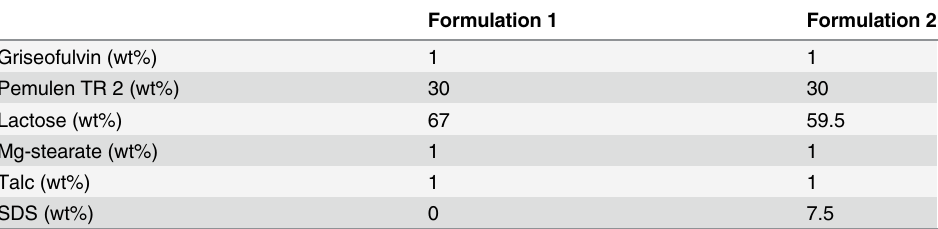
Table 1. Composition of tablets used in this